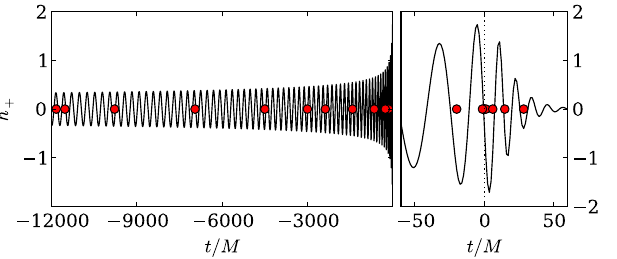
FIG. 5. Location of the empirical nodes for the fiducial family of EOB waveforms with mass ratio q ∈ ½ 1 ; 2 (cid:1) . Knowing the waveform in this parameter range at these specific times is sufficient to reconstruct the former with very high accuracy at any other time using the empirical interpolant in Eq. (18).